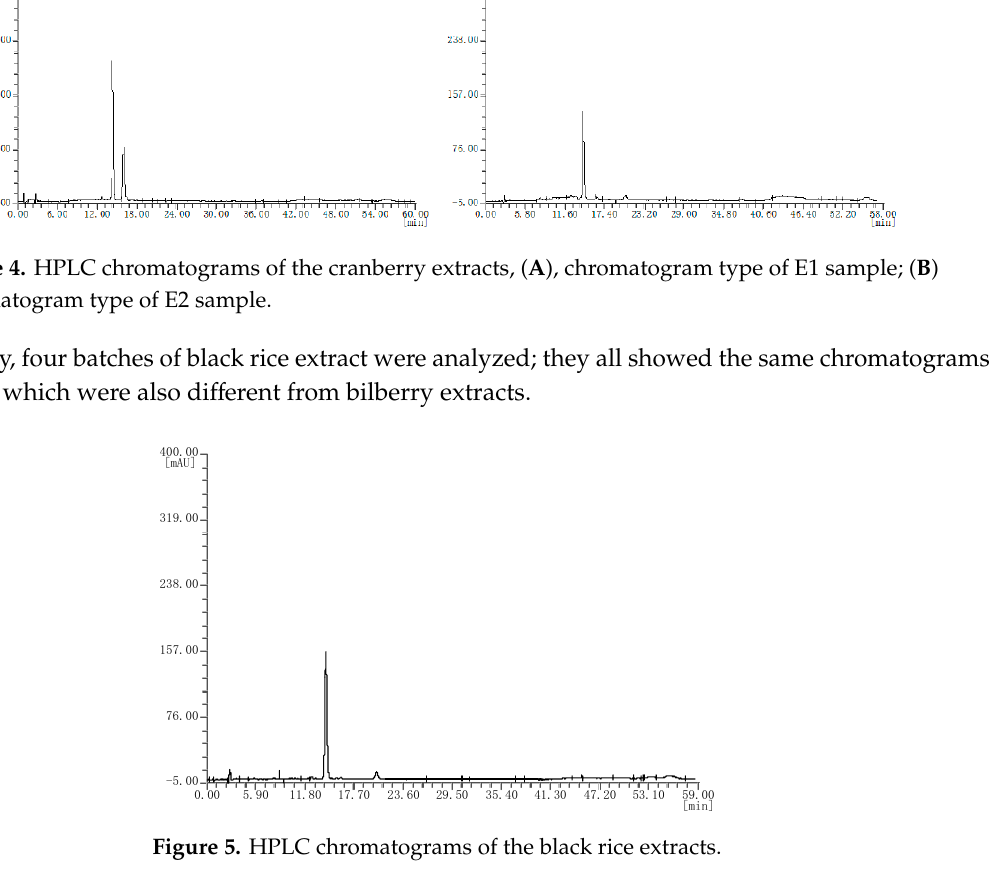
Figure 4. HPLC chromatograms of the cranberry extracts, ( A ), chromatogram type of E1 sample; ( B ) chromatogram type of E2 sample.